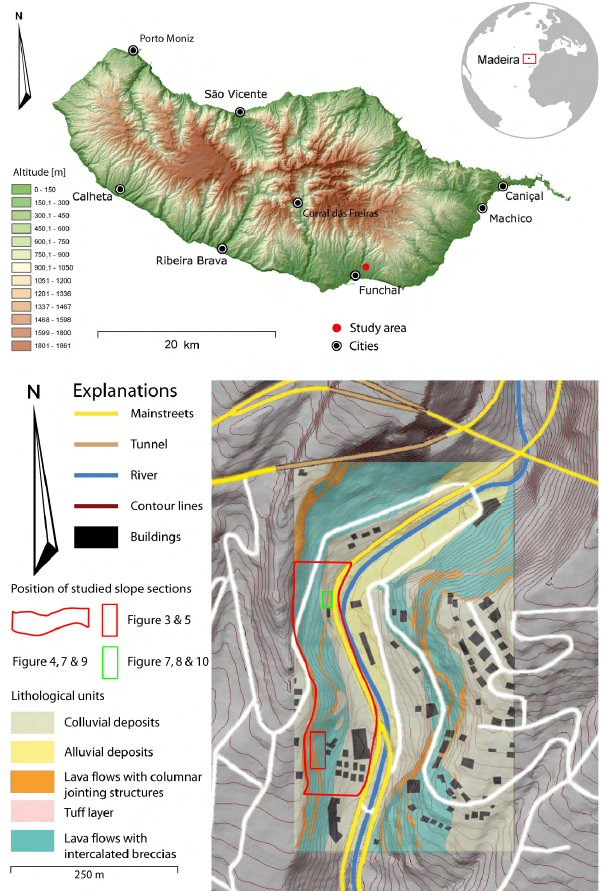
Fig. 1. Location of the volcanic island Madeira (Portugal) in the Atlantic Ocean and the extent of the study area in